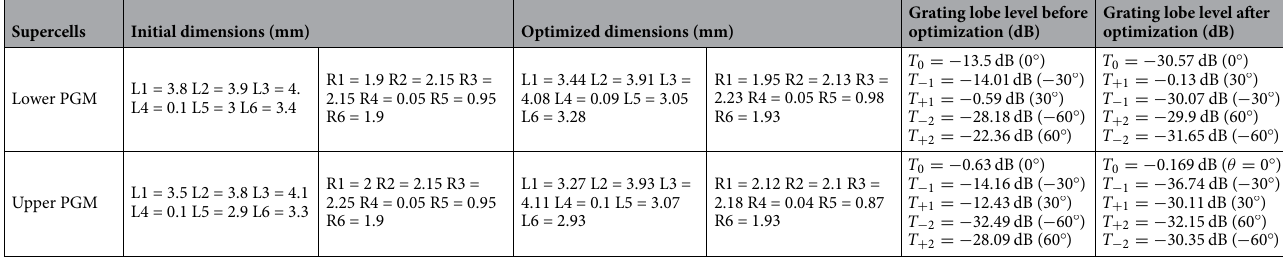
Table 2. Dimensions of supercells and grating lobe levels before and after optimization ( mm ).